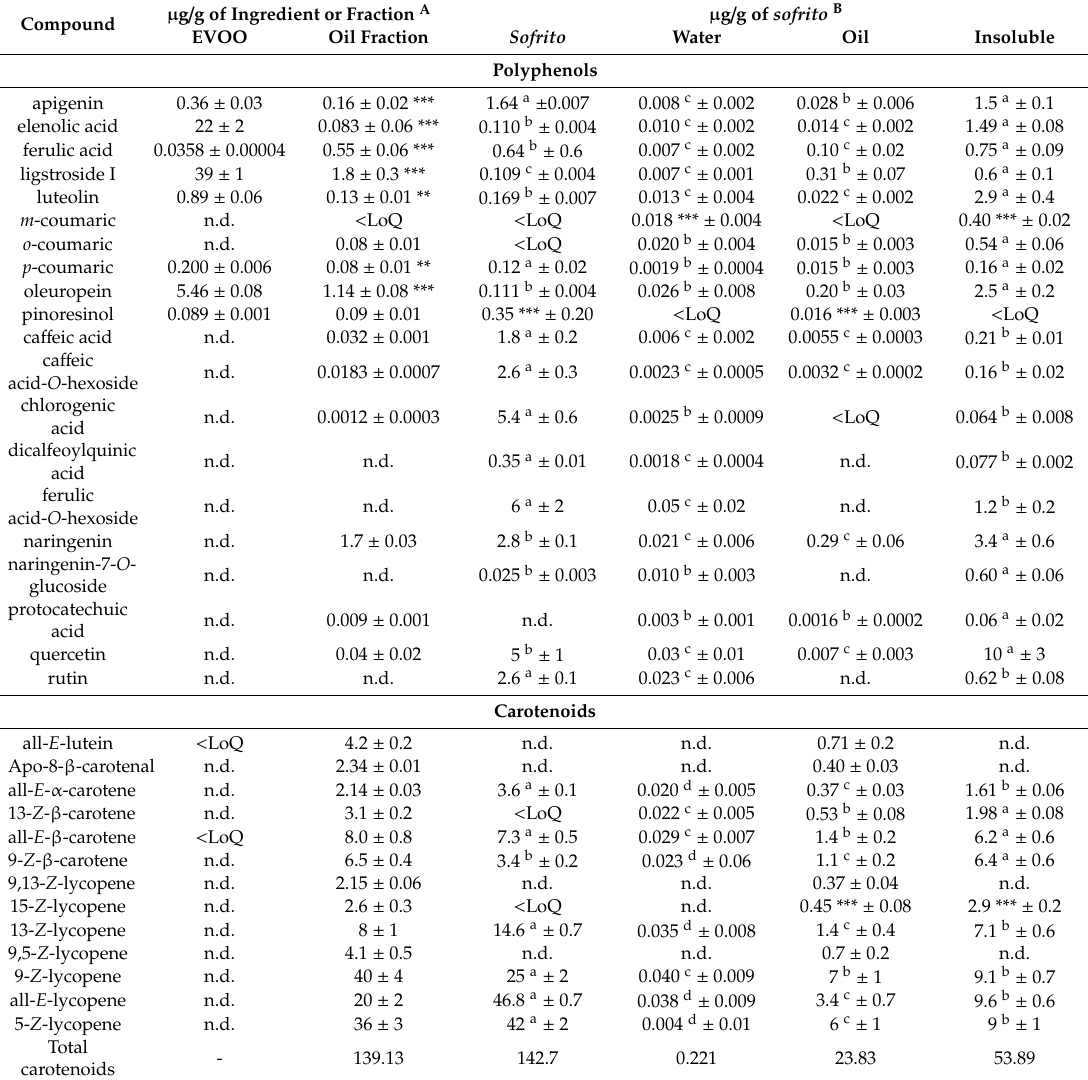
Table 3. Quantification of polyphenols in water, oil and insoluble fractions of sofrito expressed in µ g / g of sofrito or